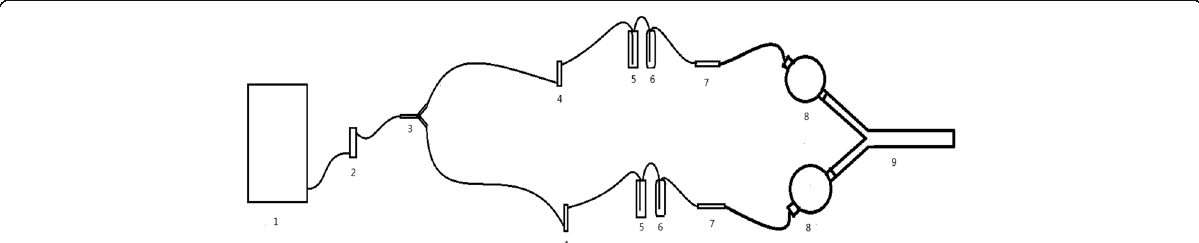
Fig. 1 Diagram of Y-tube olfactometer. 1: air generator; 2: main flow meter; 3: split-flow Y-tube; 4: flow meter; 5: activated carbon filter; 6: pure water; 7: the odour of treatment and the control; 8: ball-shaped trap; 9: Y-tube